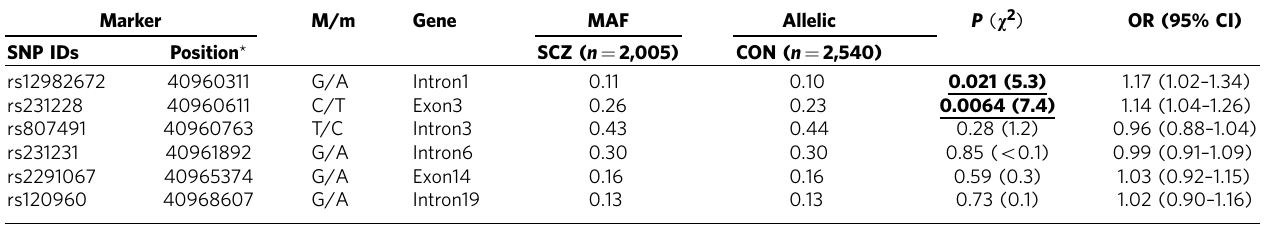
Table 1 | Allelic frequencies of SNPs in the ARHGAP33 among schizophrenia patients and controls.